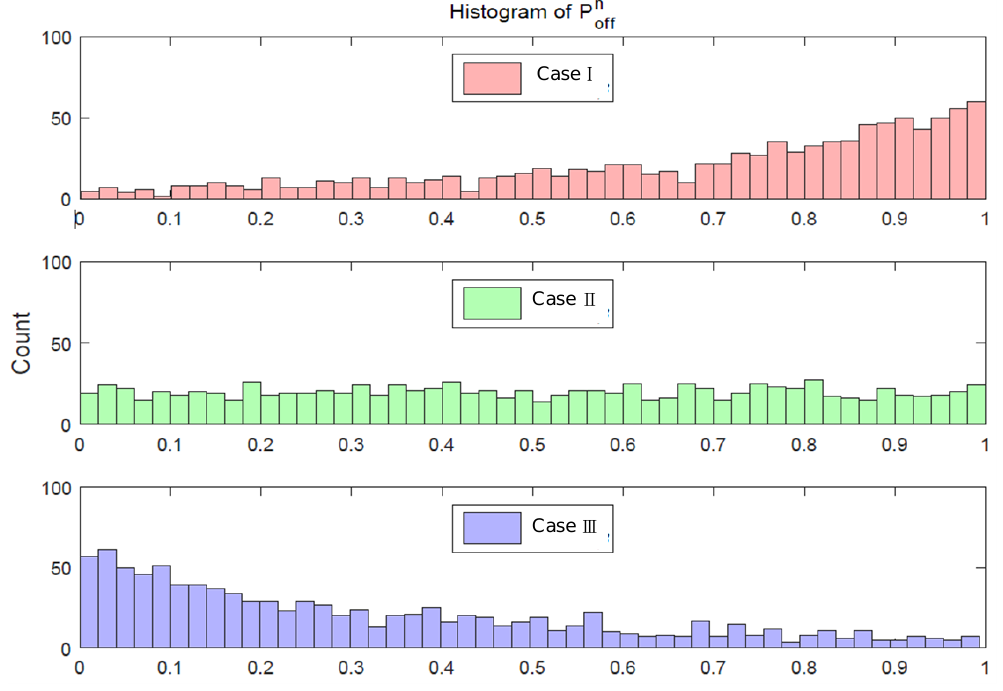
Figure 5. Off-state probability histogram of the primary